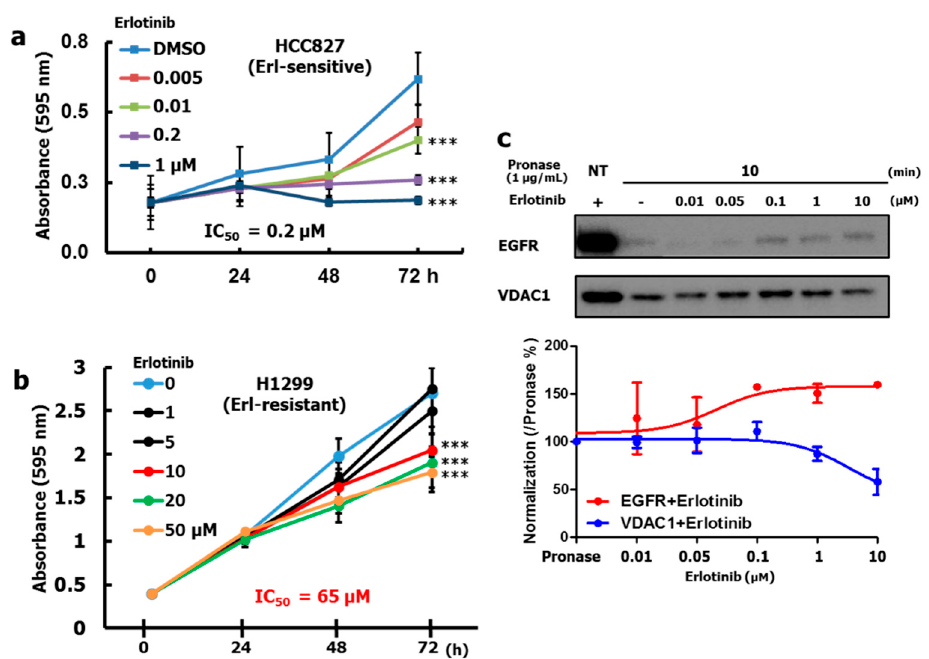
Figure 1. Selection of the Erlotinib-resistant H1299 cell line and Erlotinib binding a ffi nity for its target protein EGFR. ( a , b ) anti-proliferative e ff ect of Erlotinib in MTT assays in HCC827 (EGFR exon 19 deletion, Erlotinib-sensitive cell line) and H1299 (EGFR WT, Erlotinib-resistant cell line). *** p < 0.001, as determined by Student’s t -tests; ( c ) DARTS western blotting demonstrating EGFR binding status to Erlotinib. DARTS analysis for detection of EGFR and VDAC1 as an Erlotinib non-binding protein control. H1299 cells were lysed, diluted to 1 mg / mL, and treated with 0.01~10 µ M Erlotinib. Next, pronase was administered at 25 ◦ C over a time course. The graph below the western blot shows the quantification of EGFR (Red) and VDAC1 (Blue) in triplicate experiments. For more details, see Materials & Methods of the main text.